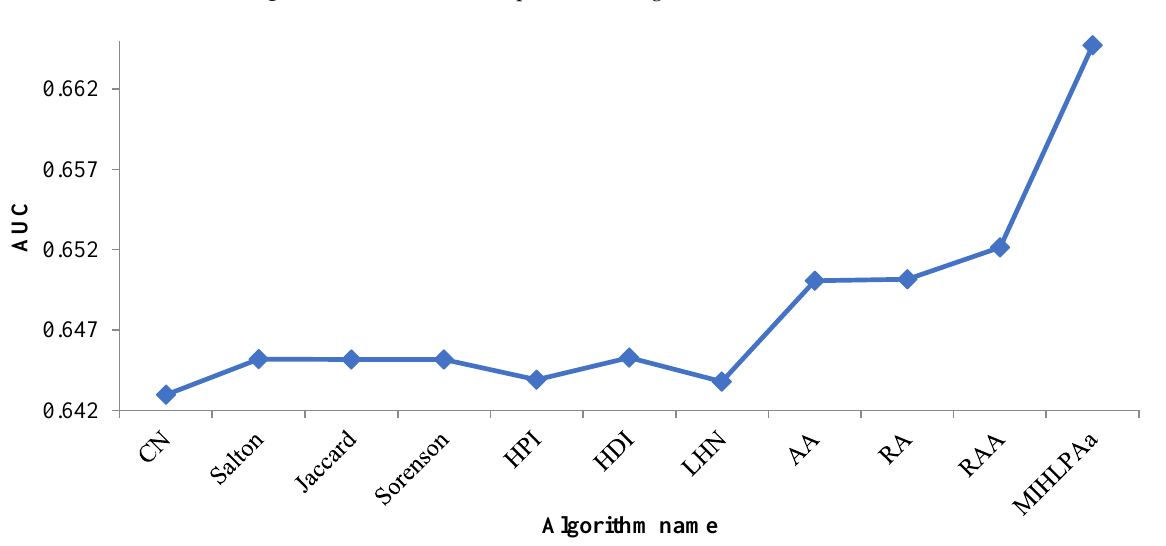
Figure 4. Performance comparison of single NB and non-combined SDIs.